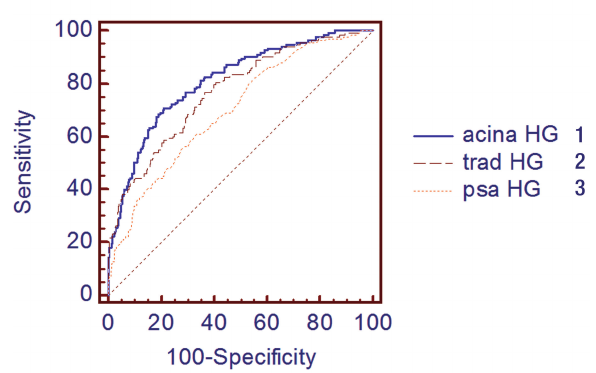
Figure 4 - ROC for high grade cancer. Comparing prostatocrit model with clinic model and PSA